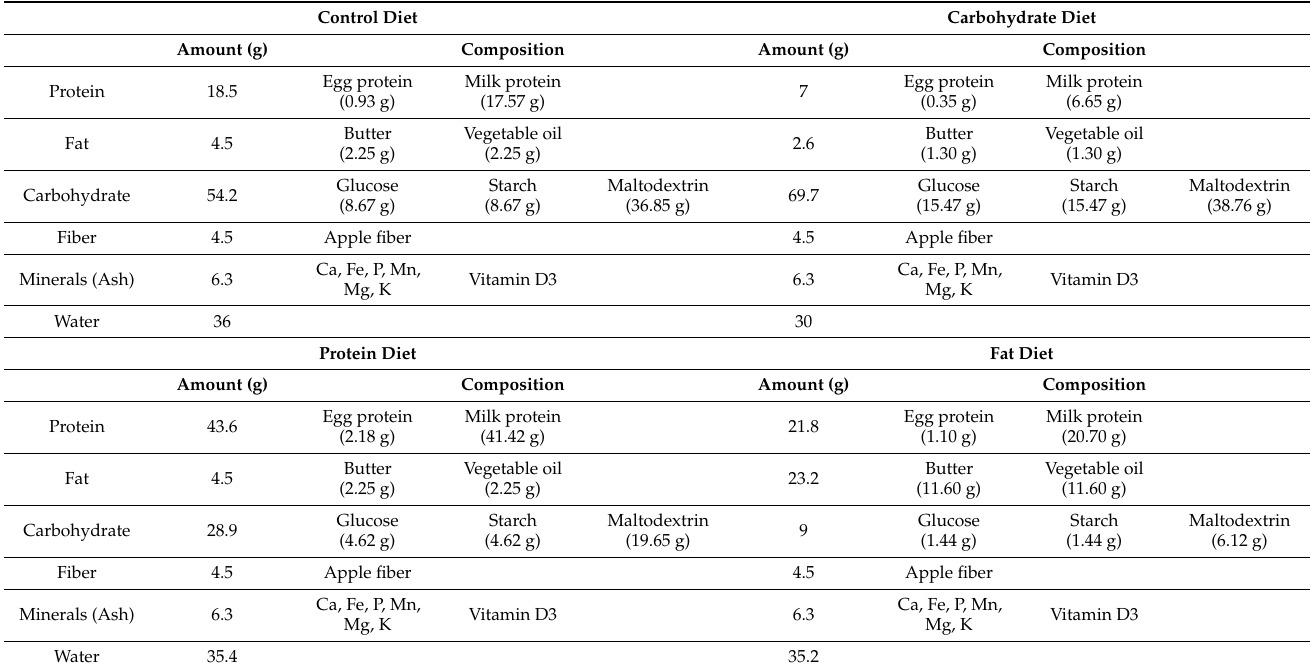
Table 1. Composition of the different dietary